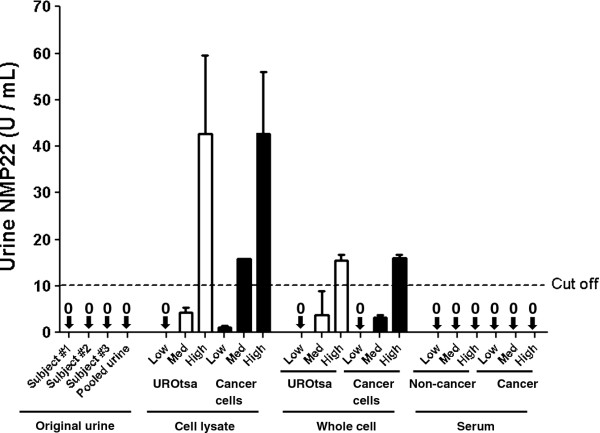
NMP-22 ELISA assay of the experimental model. Positive NMP assays were elicited by high concentrations of UROtsa cells, pooled cancer cells, cell lysate from UROtsa, and medium and high concentrations of cell lysate from pooled cancer cells. Mean levels are depicted by long horizontal lines. Error bars indicate standard deviations.